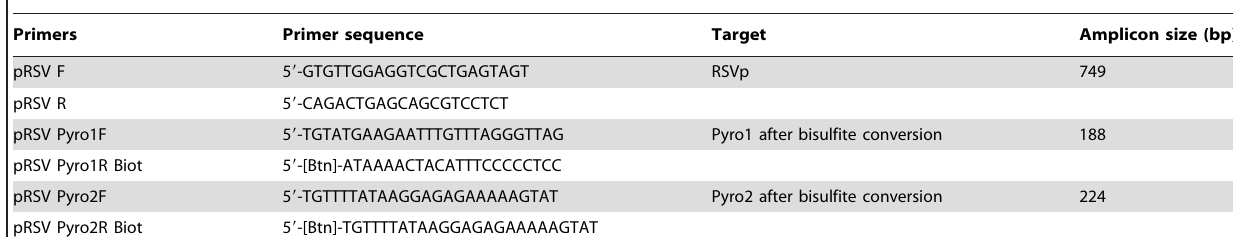
Table 1. PCR primers used for RSVp methylation analysis.